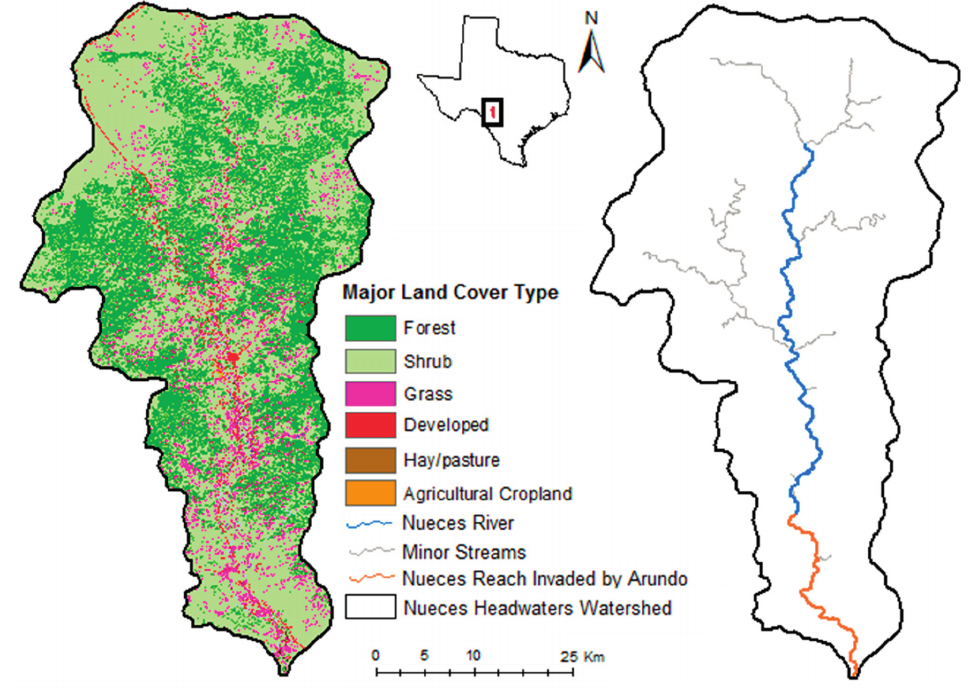
Figure 1. Land cover in the Nueces Headwaters Watershed (HUC 12110101) in